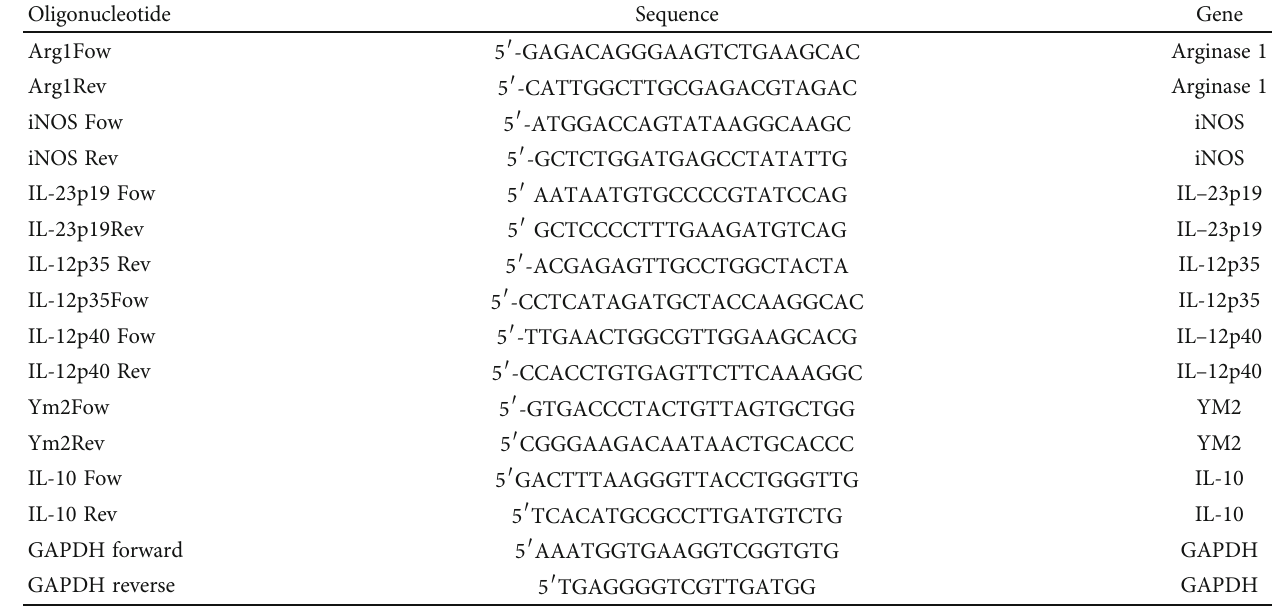
Table 1: Oligonucleotides used for ampli fi cation, sequence, and gene of each target gene.